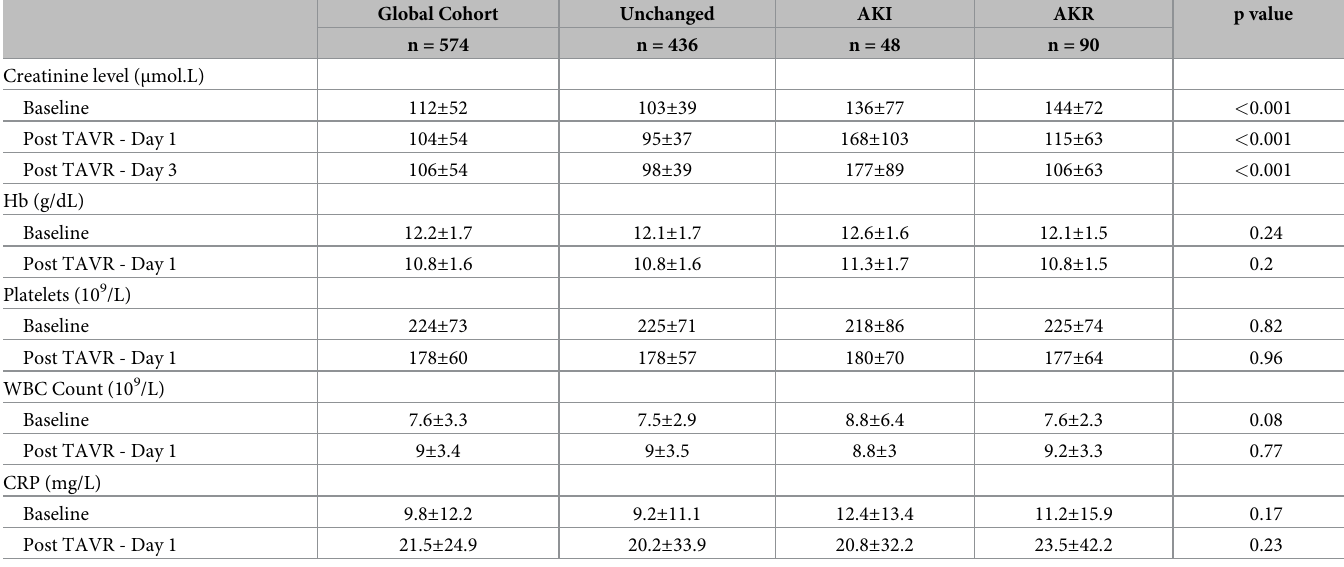
Table 3. Biological parameters.